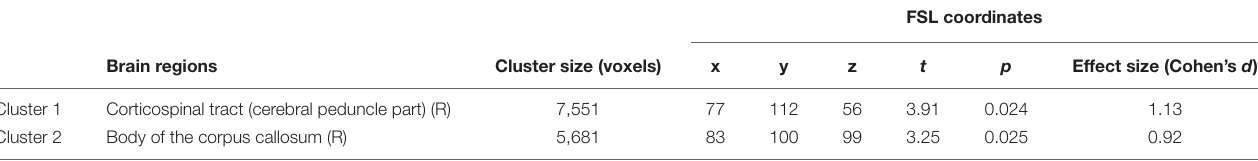
TABLE 2 | Correlation analysis between figural originality and mean fractional anisotropy (FA) showing two significant